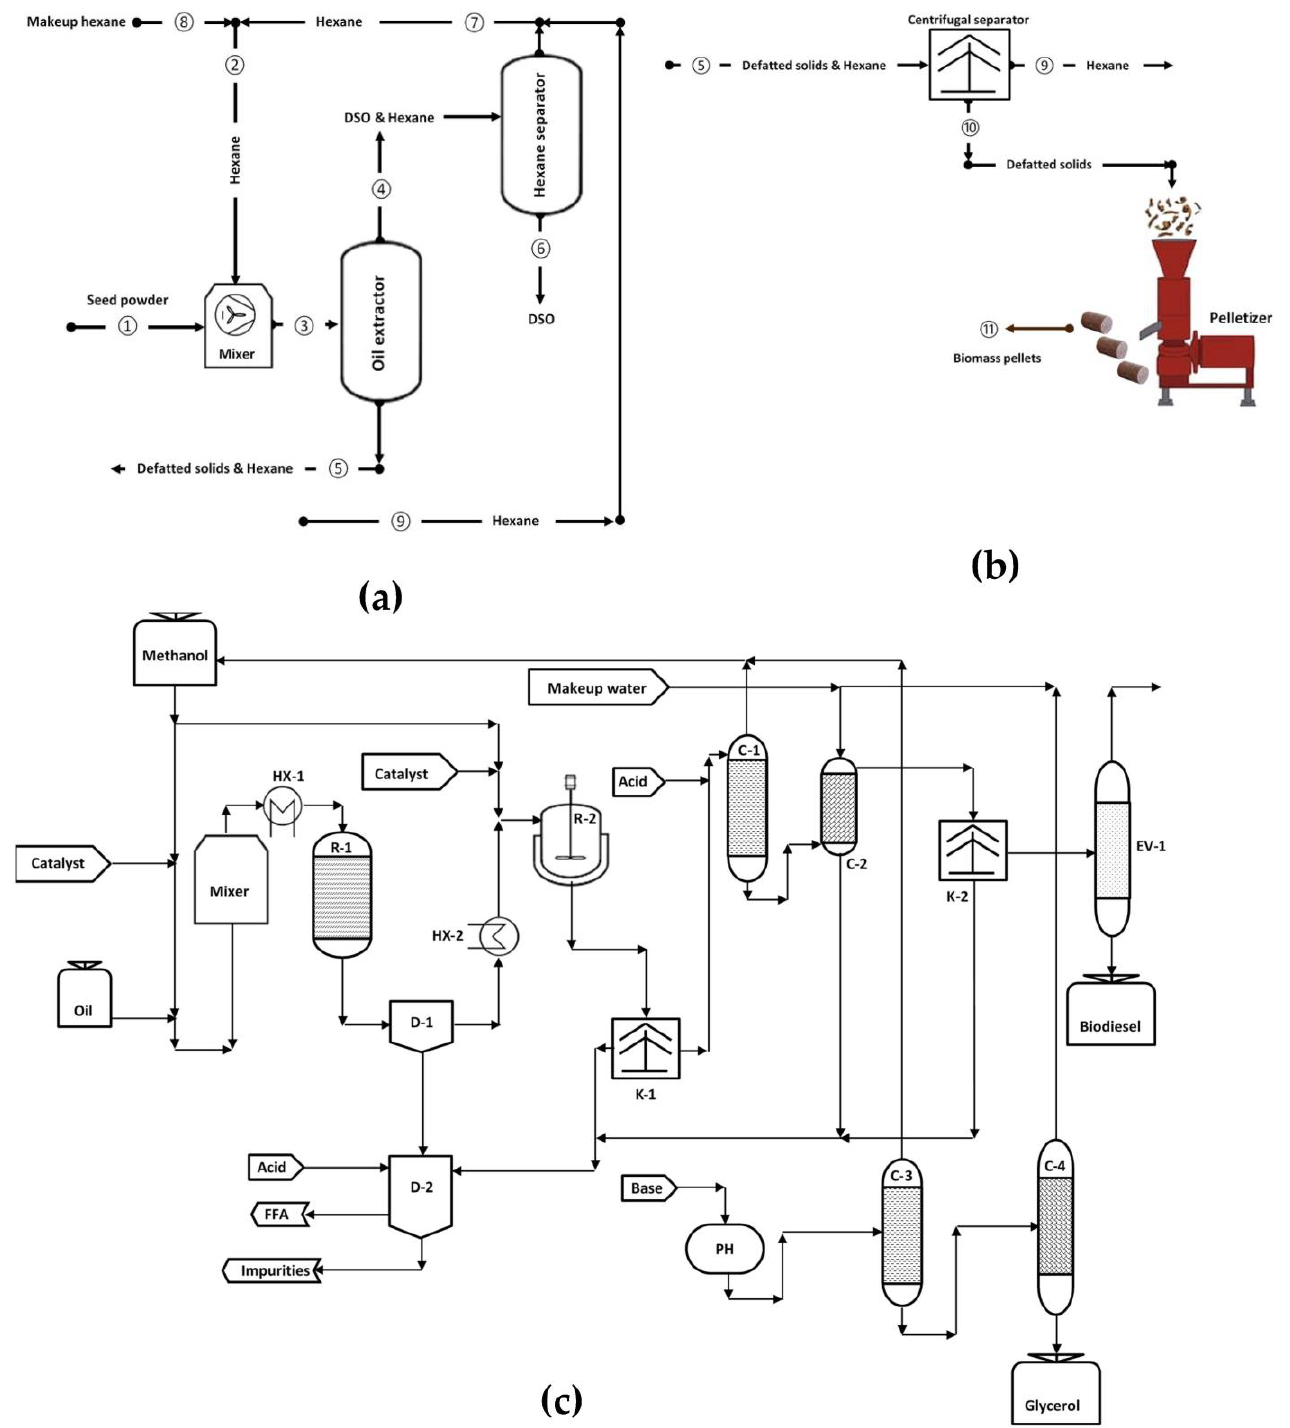
Figure 2. Flow chart of relevant processes for DSO biodiesel production plant: ( a ) oil extraction, ( b ) biomass pellet production, and ( c ) biodiesel production [27].